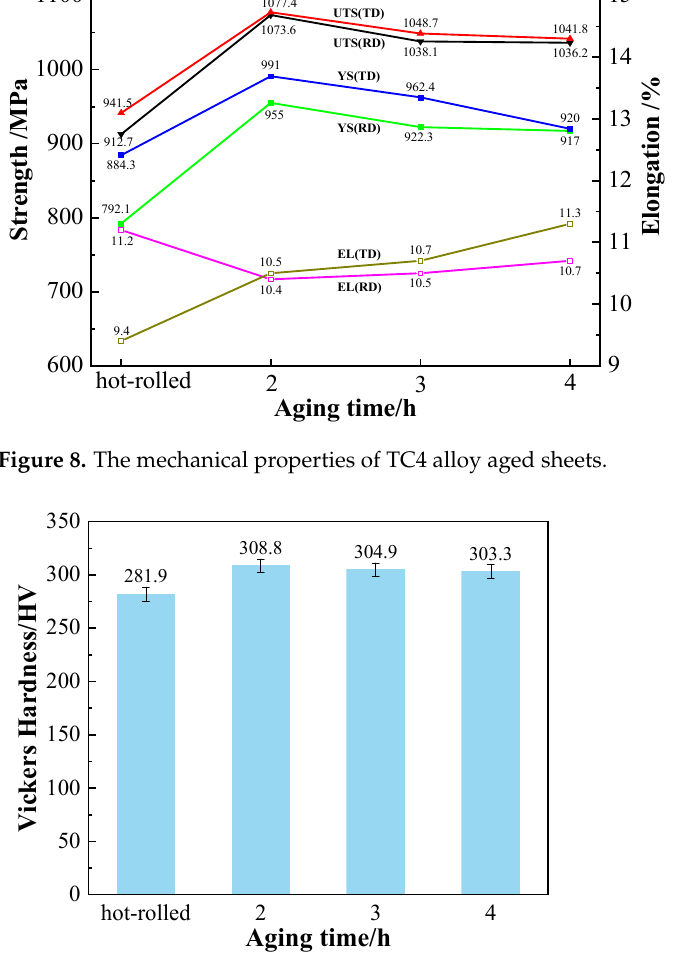
Figure 9. Vickers hardness of TC4 alloy aged sheets.